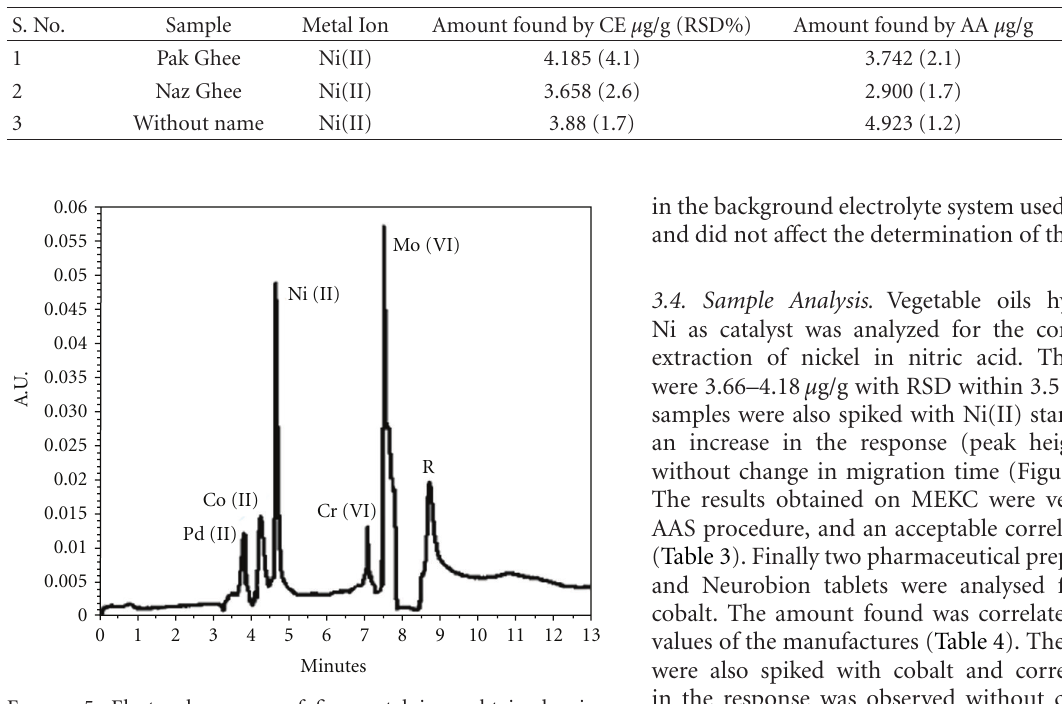
Figure 5: Electropherogram of five metal ions obtained using 25mM borate bu ff er of pH 9.1 containing CTAB (30%, 100mM) and organic modifier (butanol) in ratio of (70:30: 5v/v/v). Con- ditions: capillary, fused silica 52 cm (e ff ective length 40 cm), i.d. 75mm, applied voltage − 10kV at reverse polarity, hydrostatic injection 4sec. UV-VIS detection at 225 nm, capillary temp, 25 ◦